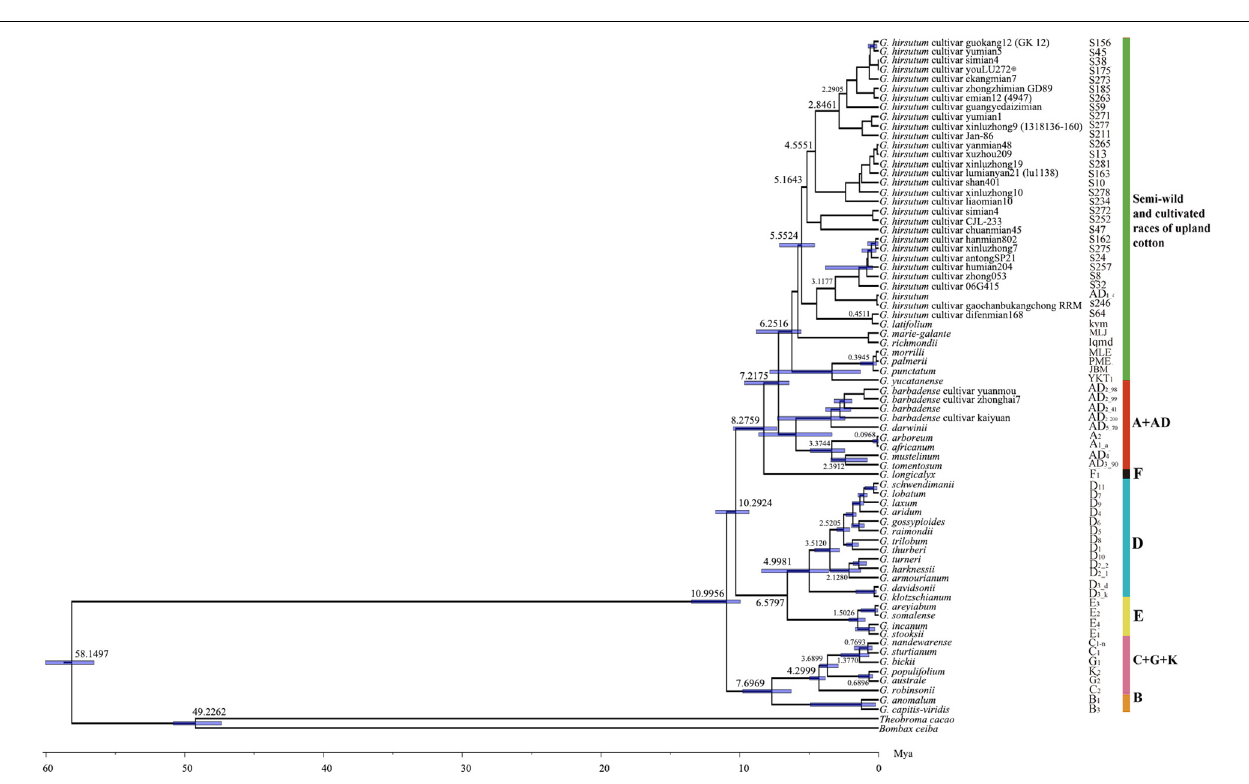
Frontiers in Plant Science |